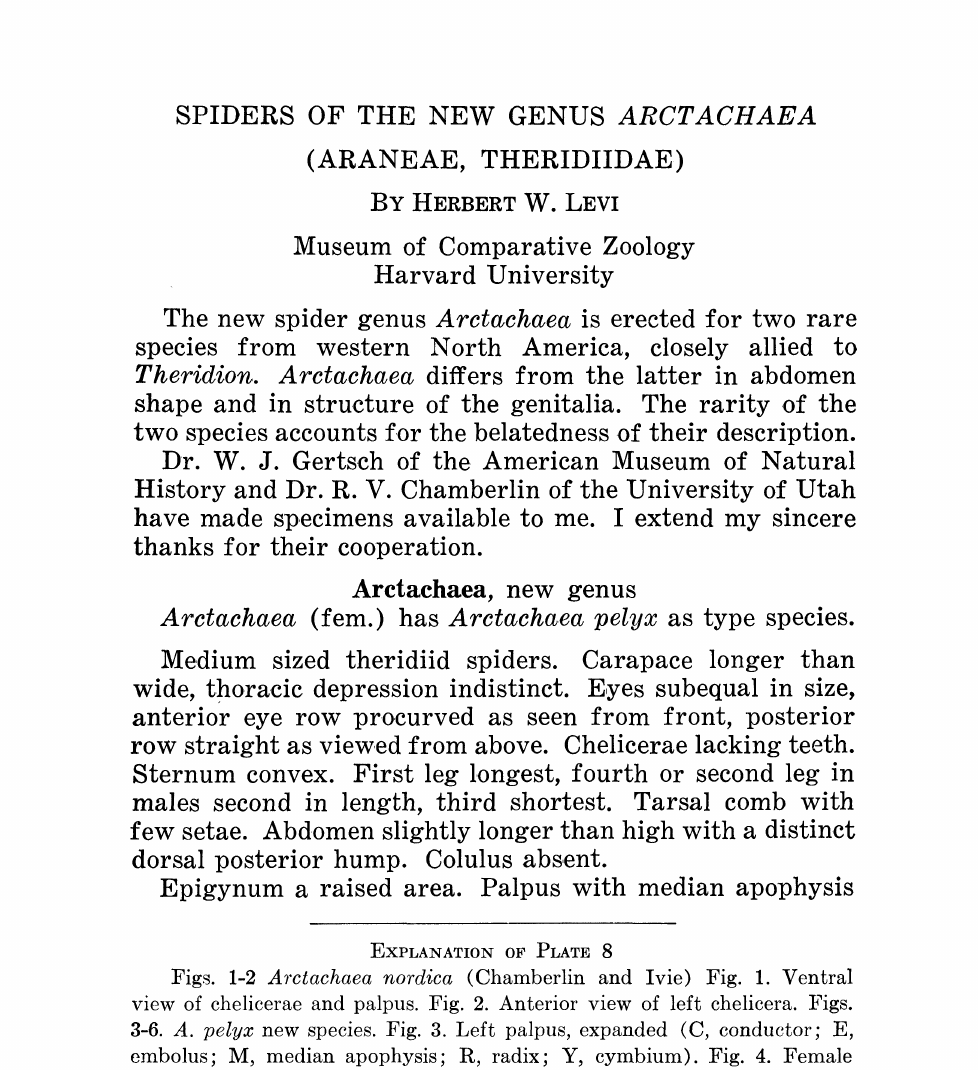
Figs. 1-2 Arctachaea nordica (Chamberlin and Ivie) Fig. 1. Ventral view of chelicerae and palpus. Fig. 2. Anterior view of left chelicera. Figs. 3-6. A. pelyx new species. Fig. 3. Left palpus, expanded (C, conductor; E, embolus; M, median apophysis R, radix; Y, cymbium). Fig. 4. Female genitalia, dorsal view. Fig. 5. Epigynum. Fig. 6. Female. Figs. 7-11. A. nor- dica (Chamberlin and Ivie). 7. Female genitalia, dorsal view. 8. Epigynum. 9, 10. Female. 11. Left palpus. Figs. 12-13. A. pelyx new species. 12. Pal- pus (Utah). 13. Palpus